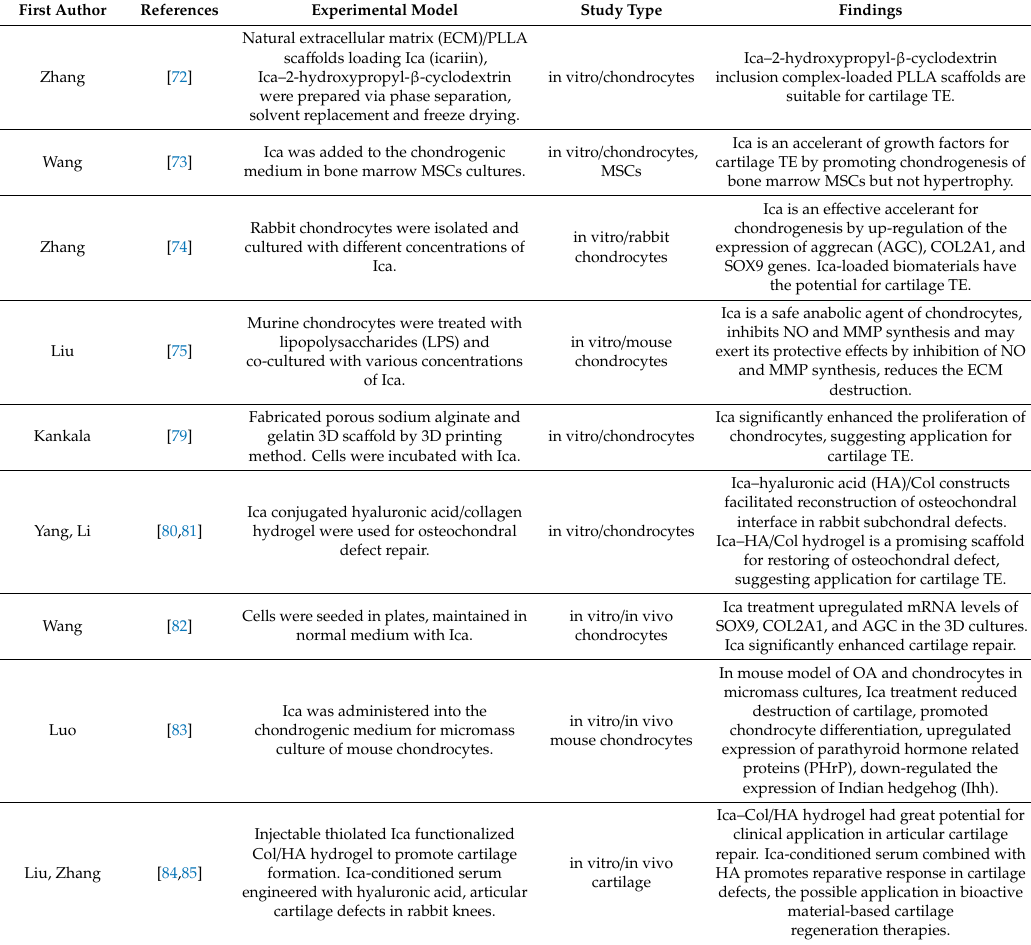
Table 3. Icariin application in cartilage tissue